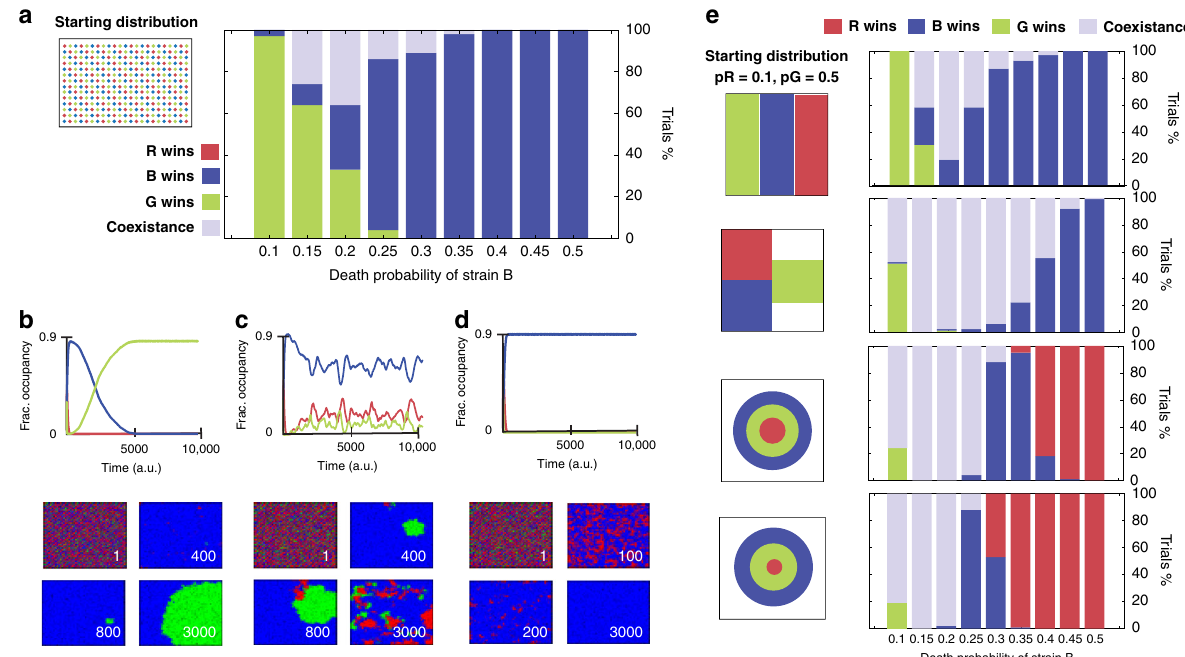
Fig. 4 Model simulations exploring spatial patterns and parameter space. a In this simulation the starting condition is an ordered array of alternating strains. The bar plots shows the outcome of 100 trials for multiple parameters of Pb (Probability of death of strain B). For all simulations, the probability of death of strain R (0.1) and strain G (0.5) are kept constant. b Time series representing the possible scenario where strain G wins (left-hand side of bar plot in part a ). Below, the corresponding image stills at multiple time points. c Time series representing the possible scenario where strain R B G coexist (left- hand side of bar plot in part a ). Below, the corresponding image stills at multiple time points. d Time series representing the possible scenario where strain B wins (right-hand side of bar plot in part a ). Below, the corresponding image stills at multiple time points. e We generated the same bar plots described in part a with different geometries as initial conditions.The bar plots shows the outcome of 100 trials for multiple parameters of Pb (Probability of death of strain B). For all simulations, the probability of death of strain R (0.1) and strain G (0.5) are kept